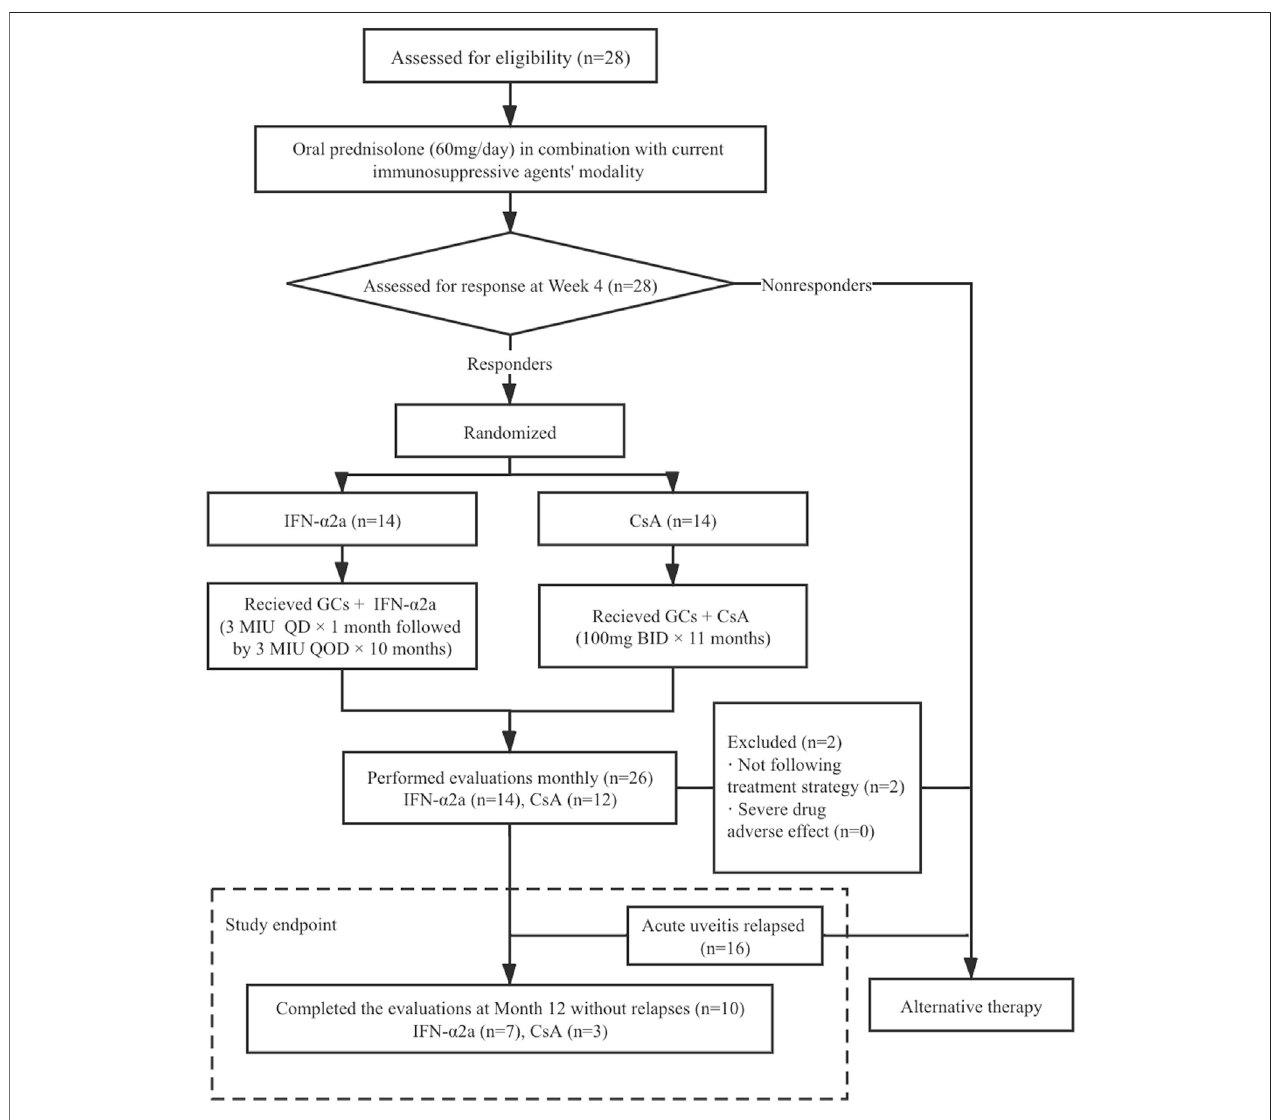
FIGURE 1 | Patient disposition and fl ow chart of the study. BID, bis in die (twice a day); CsA, cyclosporine-A; GCs, glucocorticoids; IFN- α 2a, interferon alpha-2a; MIU, million international unit; QD, quaque die (every day); QOD, quaque omni die (every other day).